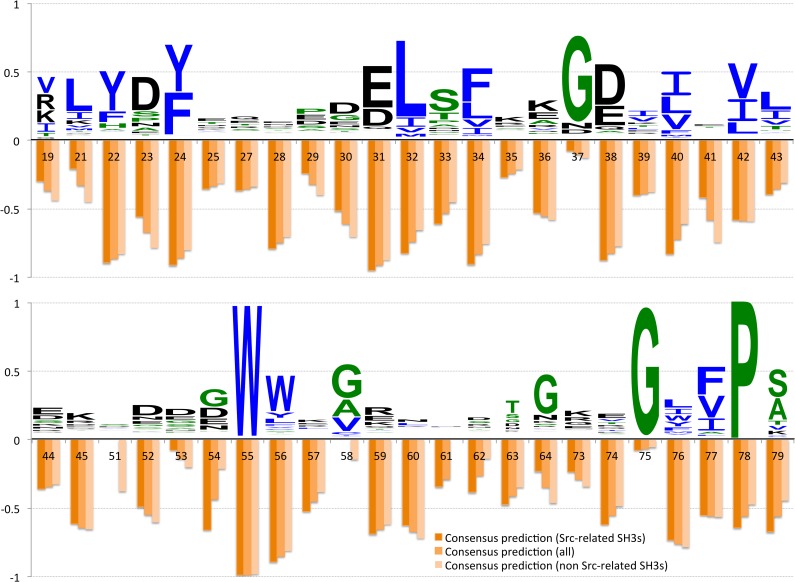
Amino acid conservation in SH3 PFAM family in relation to the consensus rankings.The three consensus rankings are compared to the residue conservation in the SH3 family. The bar chart shows, for 45 positions in the Src SH3 sequence which appear in the PFAM alignment of the complete family (see Material and Methods), the consensus scores (orange bars) derived in this paper and conservation scores derived from the full Pfam alignment of SH3 domains (PF00018) after filtering by 60% of identity (see Material and Methods) (Weblogo). The shading of the orange bars correlates with the distance of the consensus model from Src (i.e. the lighter the bar the further from Src).